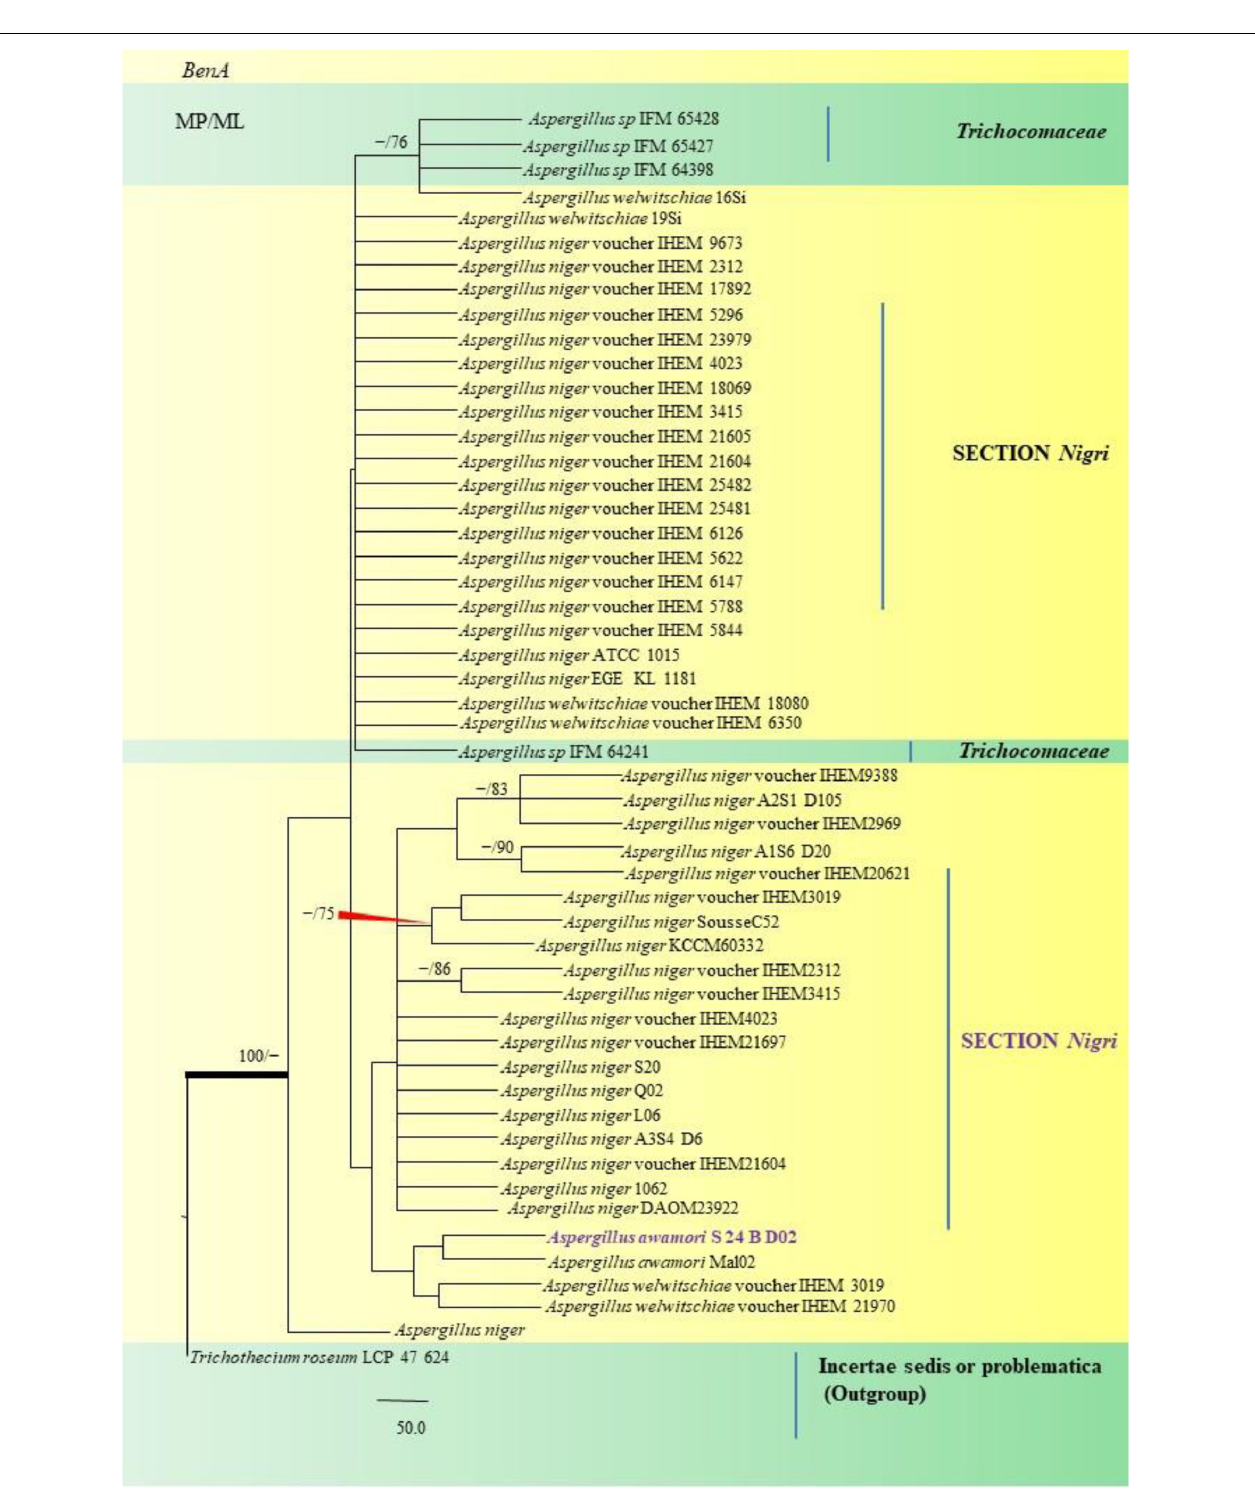
FIGURE 10 | A phylogenetic tree (taxon branching diagram) which presents the genetic analysis of the Aspergillus awamori S 24 B D02 clade belonging to the Section Nigri, exhibiting a maximum parsimony analysis of partial β -tubulin concatenated sequences, acquired. Bootstrap (bs) values ≥ 70% are designated at the nodes for maximum parsimony (MP) and maximum likelihood (ML) methods; branches with values ≥ 95% bs are bold black. A specific isolate code was mentioned as a suffix to the species name. Hyphen (-) represents the range of support values for parsimony and RAxML analyses of below 70%. Our isolate, which is marked in purple, was rooted using Trichothecium roseum LCP 47